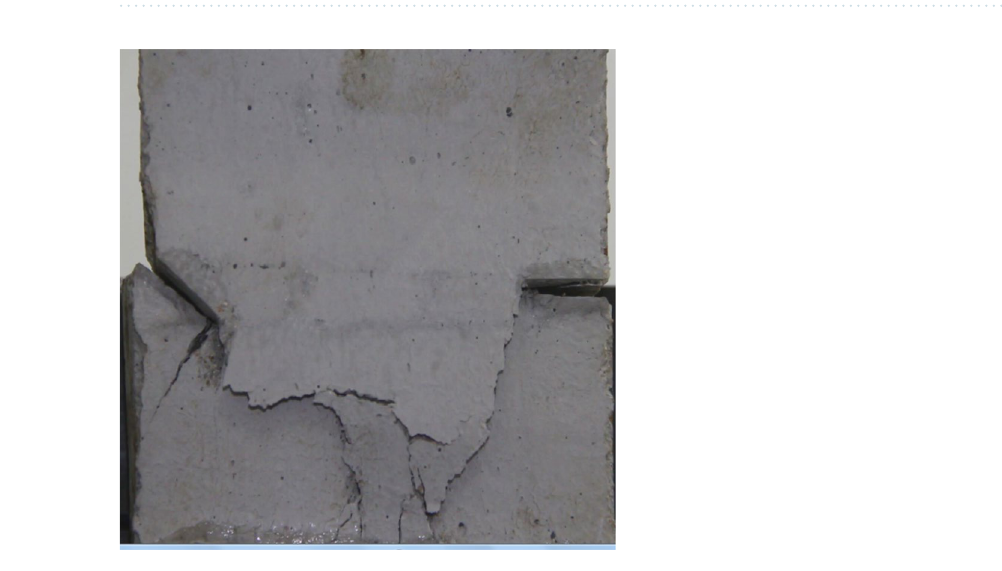
Figure 12. Photograph of a specimen showing propagated tensile wing crack.